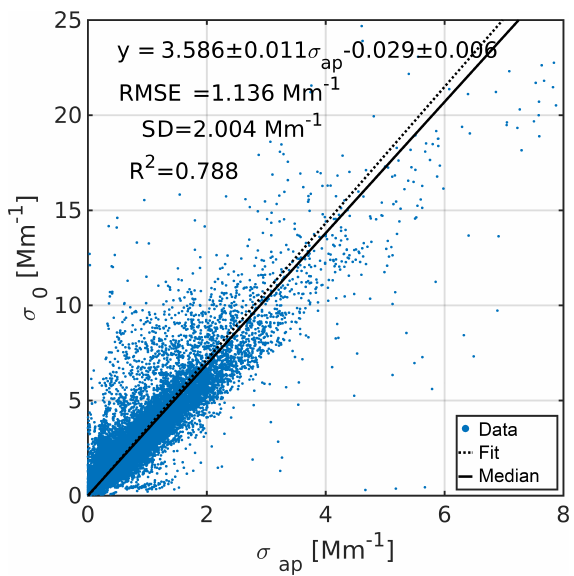
Figure 10. Attenuation coefficients ( σ 0 ) as a function of absorp- tion coefficients ( σ ap ) derived from co-located filter-based absorp- tion photometers, including all available wavelengths and all sta- tions except for Summit. To these data, using bivariate regression, a first order polynomial was fitted using averaging times as weights, shown as a dotted line. The solid line marks the weighted median C f value of 3.45. In the figure, RMSE stands for systematic root-mean- square error and STD for standard deviation. The standard deviation was calculated using the standard error (SE) of the fit and number ·√ n . R 2 is the correlation of data points ( n) as SD = SE